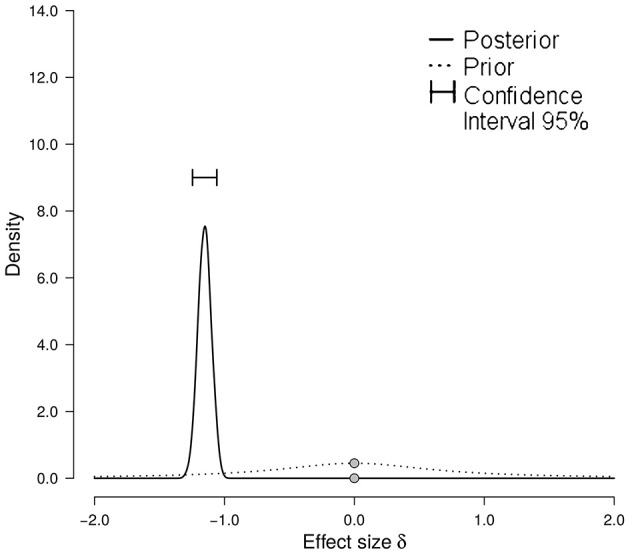
Prior and posterior distribution with Bayesian confidence interval of the effect size δ. The prior distribution (dashed line) shows the distribution expected under the null hypothesis with no data (i.e., performance at chance level). The posterior distribution (solid line) shows the distribution that is expected given the data. The point of interest (zero) is marked with gray dots on both distributions. A score of zero on the x-axis represents performance at chance level.